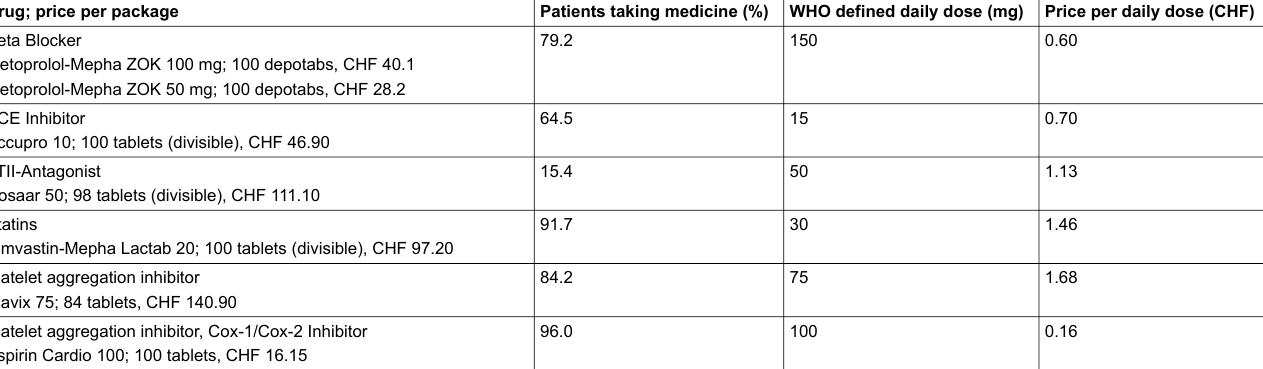
Table 5: Medication after an ACS event. Own calculation on the basis of AMIS Plus data [17], list of pharmaceutical specialties [35] and WHO Collaborating Centre for Drug Statistics Methodology [17]. Drug prices 1st of May